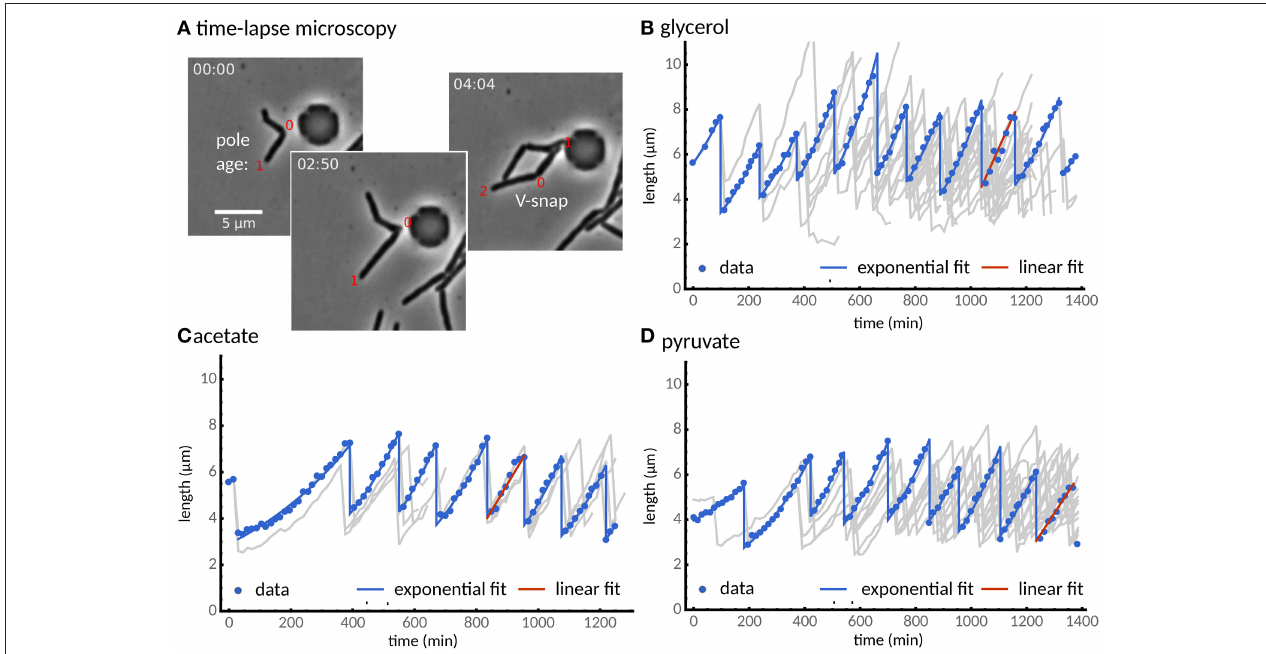
FIGURE 1 | Single cells grow exponentially under different carbon sources. (A) Time-lapse microscopy shows single cells grown with a glycerol carbon source observed from cell birth to division determined by the V-snap (from left to right). (B) Cell length vs. time for one of the longest lineage of the experiments (points). The lineage tree arising from all recorded cell divisions is shown in gray. (C,D) Two alternative carbon sources, (C) acetate and (D) pyruvate, are considered. Under all three carbon sources, most cells (about 90 % ) grow exponentially (blue lines), while some cells were better described by a linear growth model (red line). We observed that cells adapted to the experimental conditions after about two